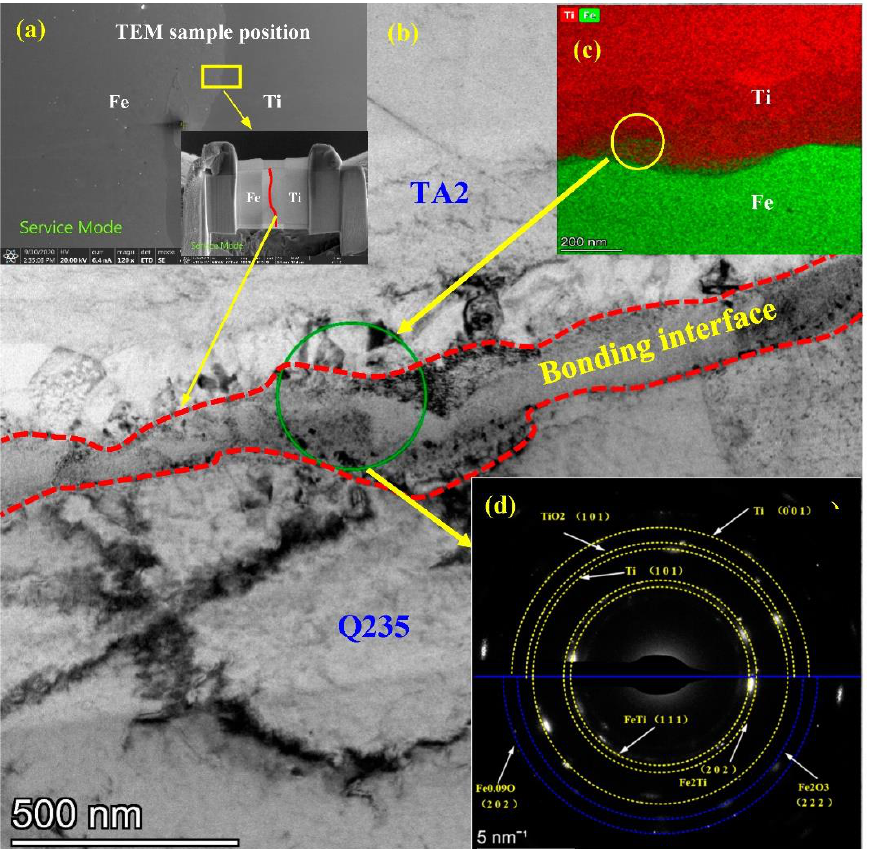
Figure 5. TEM result at the TA2-Q235 interface: ( a ) TEM sample cut perpendicular to the Ti/Fe interface and prepared by FIB; ( b ) TEM bright field image; ( c ) EDS map scanning under the TEM bright field; ( d ) the selected area electro diffraction (SAED) showing formation of nano-grained intermetallic phase in the interface region [16].